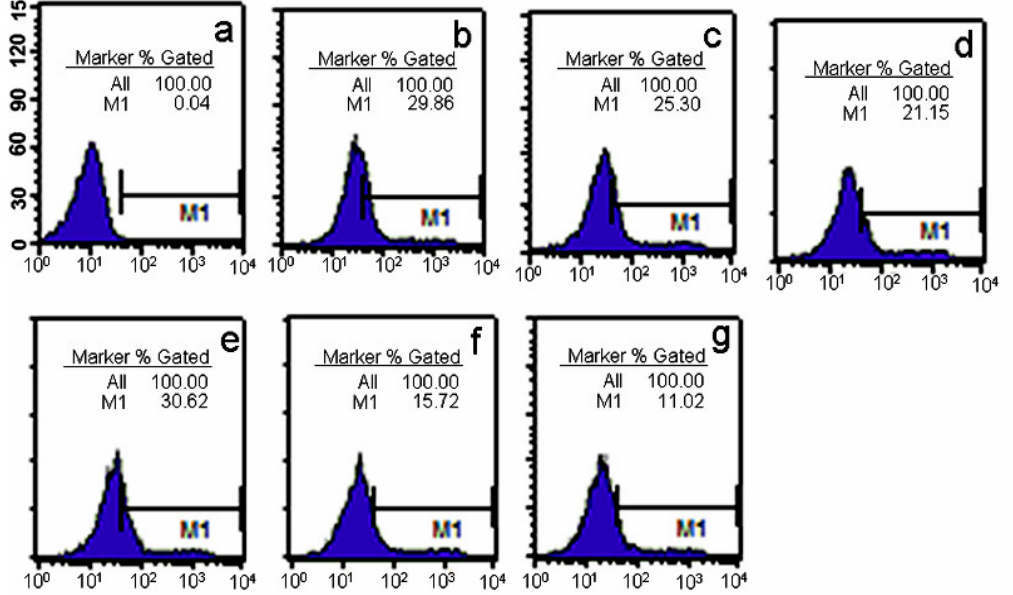
Figure 8. Flow cytometric analysis of pEGFP expression in SK-BR-3 cells using HP α - CD-PEI (N/P ratio at 50) and PEI 25 kDa (N/P ratio at 10). (a) Cells of control (untransfected), (b-d) HP α -CD-PEI (b, in 10% FBS; c, in 50% FBS; d, in 100% FBS), (e- g) PEI 25 kDa(e, in 10% FBS; f, in 50% FBS ; g, in 100%